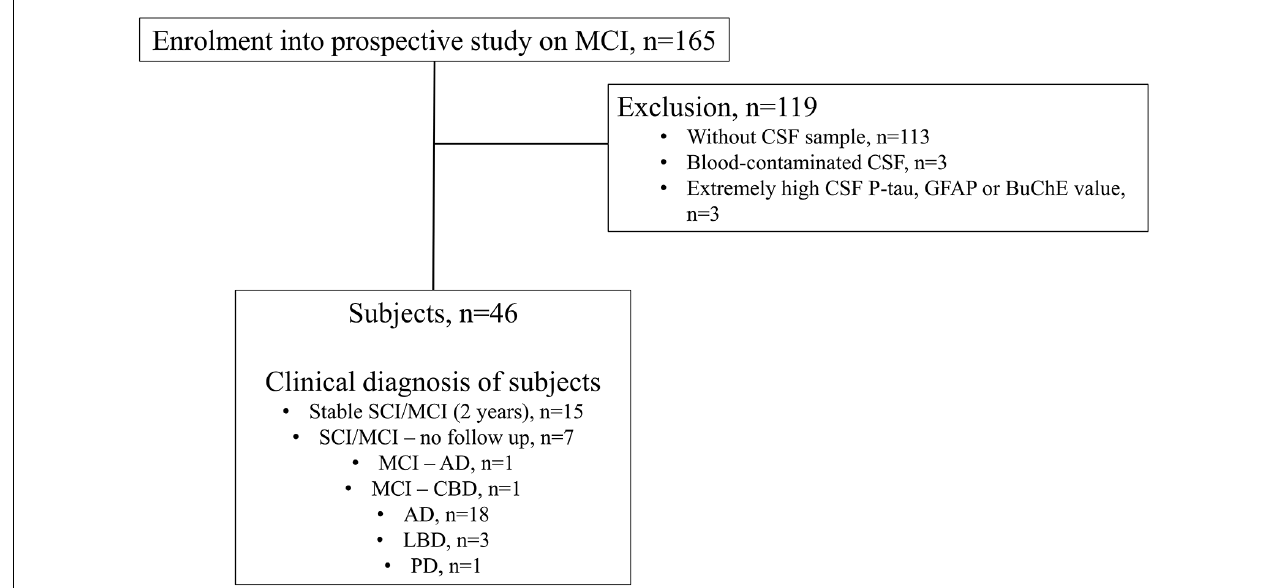
FIGURE 1 | Flow chart illustrating the inclusion/exclusion criteria for the study and clinical diagnosis of subjects.